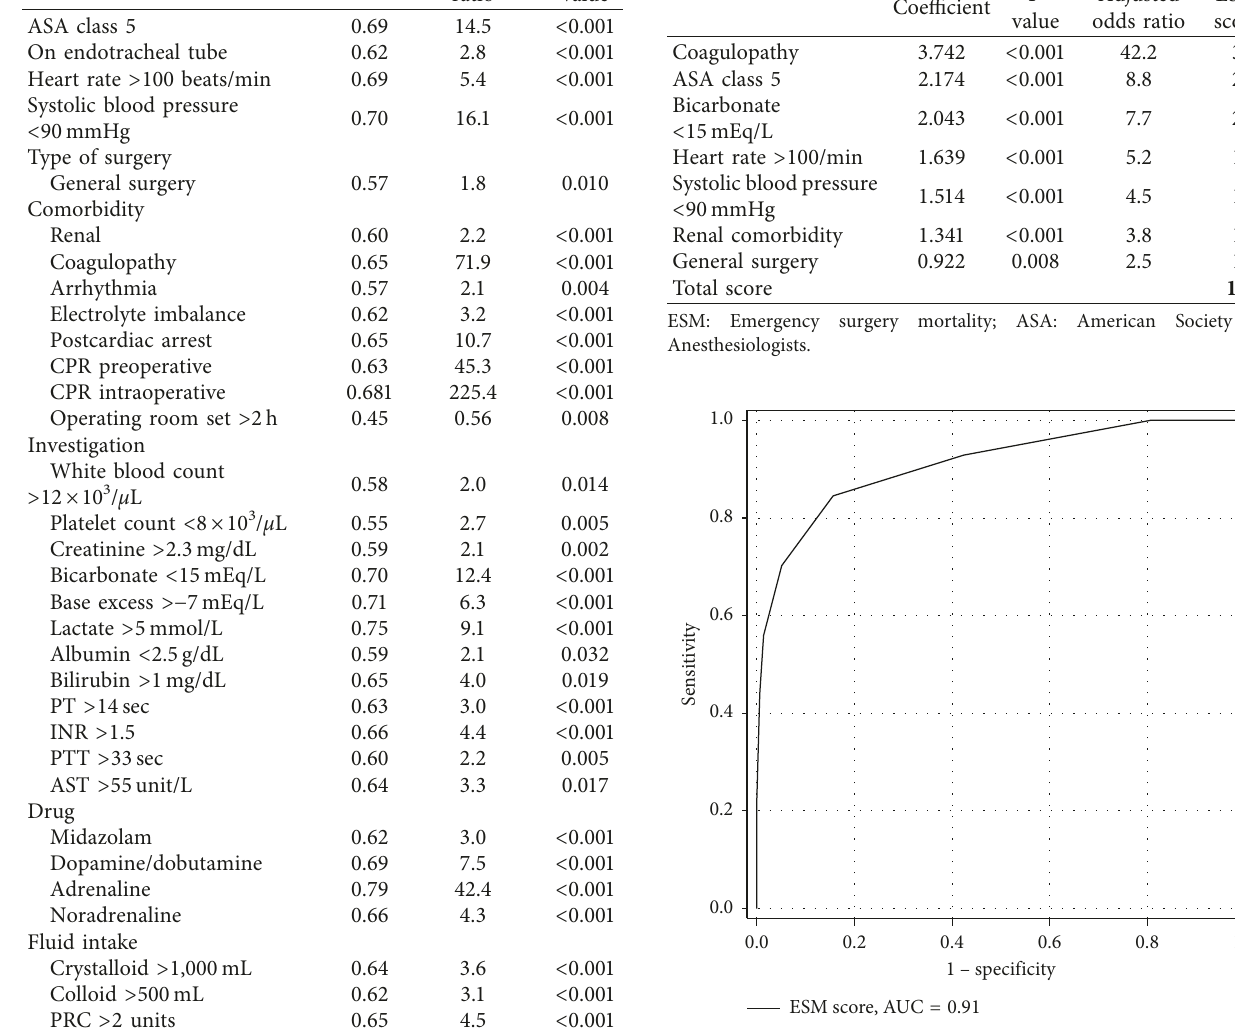
Figure 1: AUC of ESM score to predict mortality in the Training group. ESM: Emergency surgery mortality; AUC: area under the receiver operating characteristic